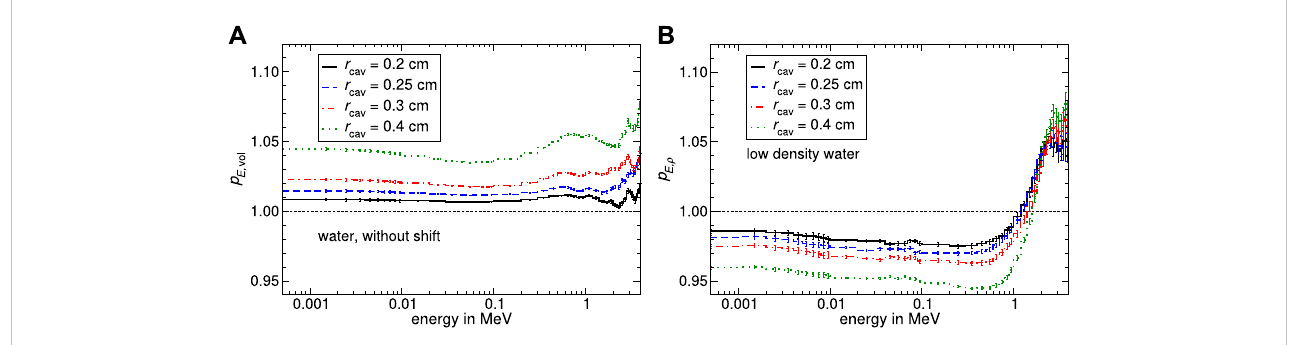
FIGURE 6 Monte Carlo calculated volume-averaging correction factor p E ,vol and density correction factor p E , ρ as a function of energy in the build-up region determinedbythefactorizationoftheinternal fl uencecorrectionfactorshowninFigure5A.Thespectralvolume-averagingcorrectionfactor p E ,vol isshownin panel (A) . In sub fi gure (B) The density effect correction factor p E , ρ as a function of energy was calculated by the quotient of p E ,int divided by p E ,vol as shown in Figure 2. The uncertainty varies depending on energy in a range of 0.09% – 0.5% for panel (A) and 0.14% – 1.8% for panel (B) .